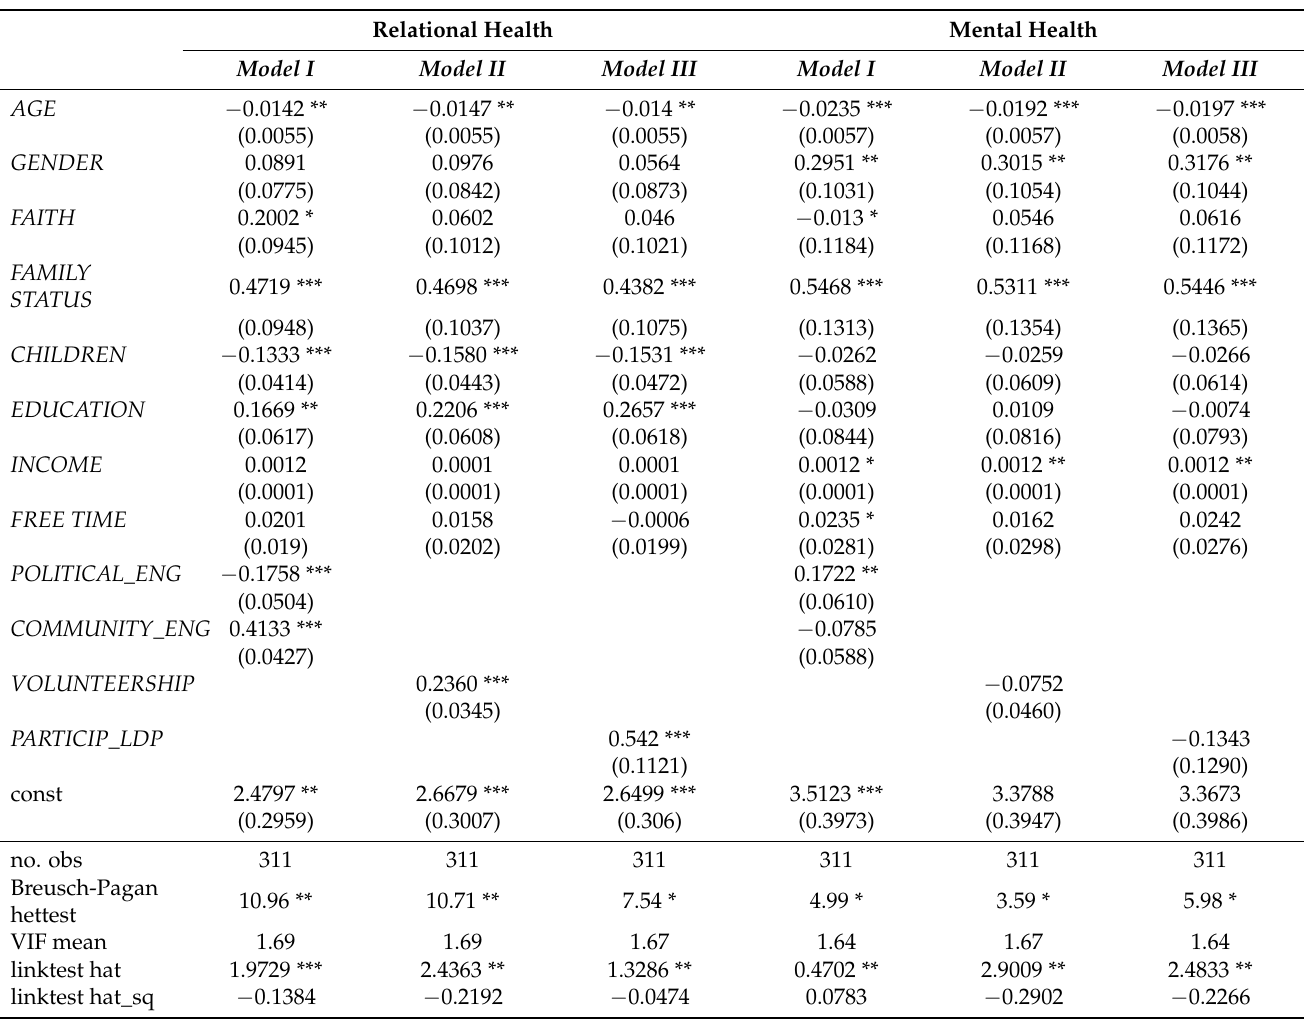
Table 4. Results of cross-sectional regression